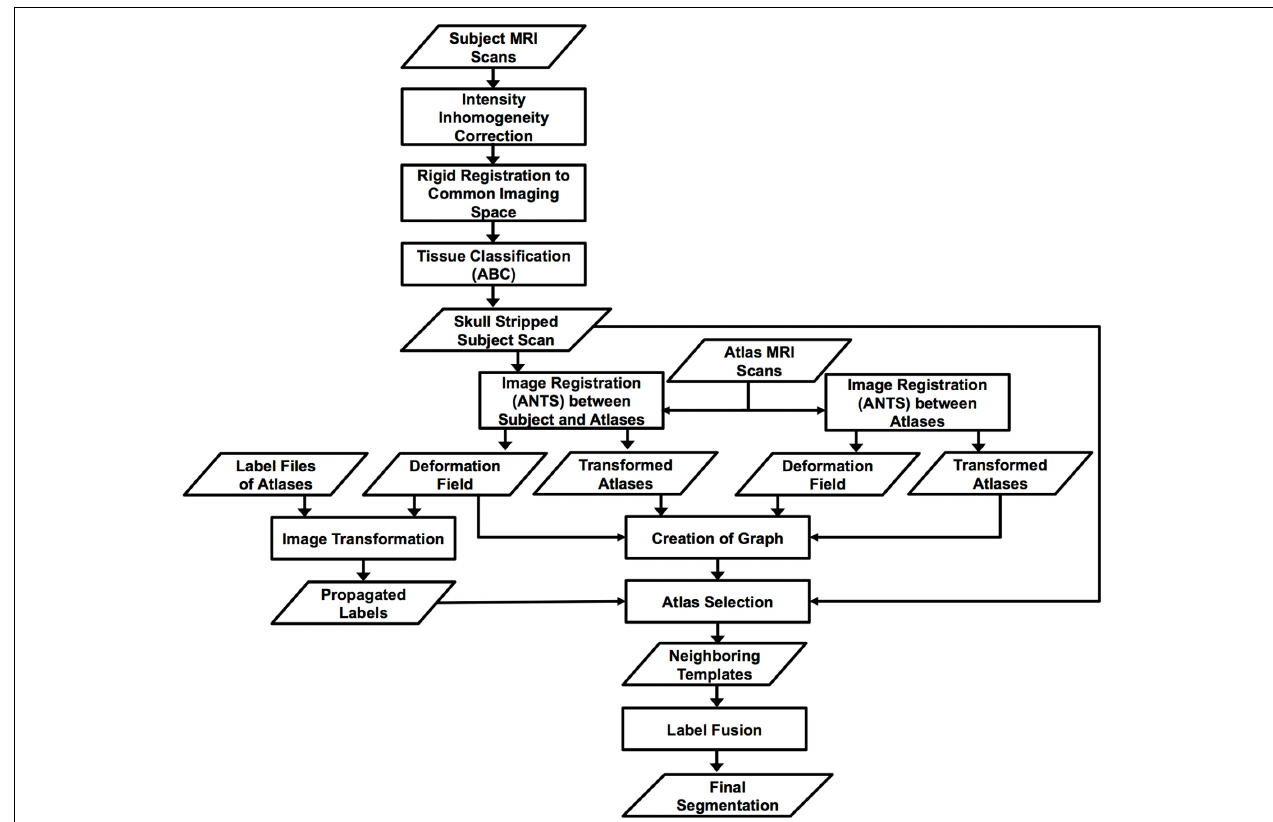
FIGURE 1 | Overall computational scheme of AutoSeg with multi-atlas segmentation.